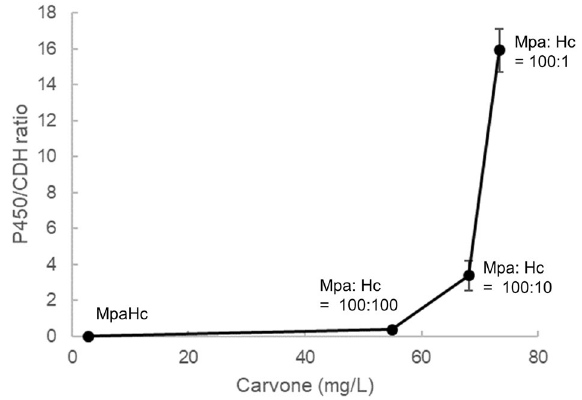
Figure 6. Correlation of the P450/CDH protein ratio and the amount of carvone produced. The P450/CDH ratio was calculated based on quantification concatamer (QconCAT) proteome analysis, and its correlation with carvone production is shown. Each plot on the graph represents four different conditions. From left to right: MpaHc (BL21(DE3) pCDF-CYP71D18-ATR2, pET-ISPD) showing a P450/CDH ratio of 0.004, Mpa (BL21(DE3) pCDF-CYP71D18-ATR2) and Hc (BL21(DE3) pET-ISPD) mixture (100:100) showing a P450/ CDH ratio of 0.388, Mpa and Hc mixture (100:10) showing a P450/CDH ratio of 3.4, and Mpa and Hc mixture